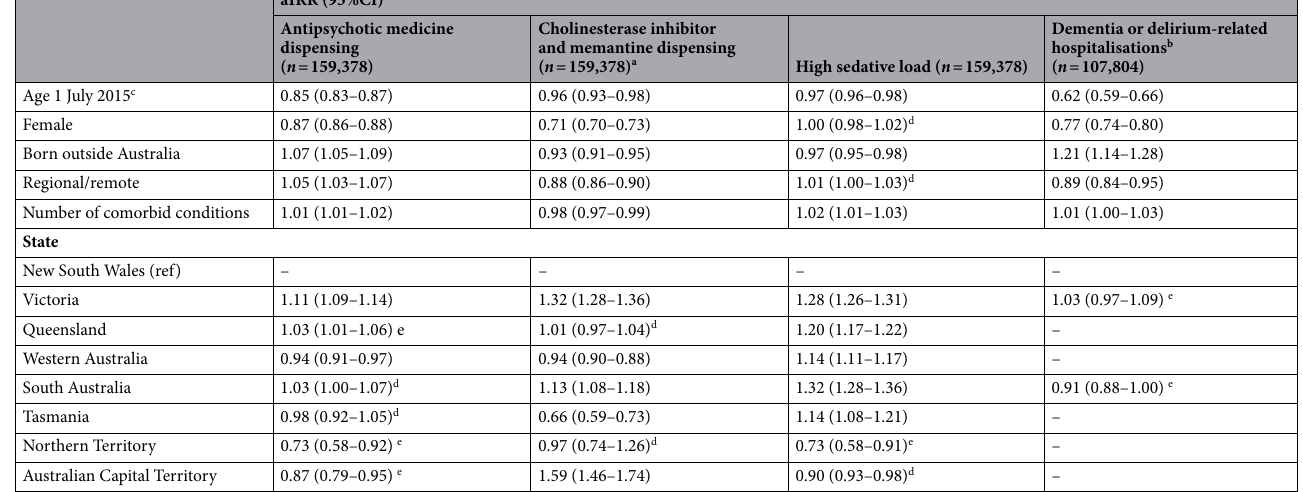
Table 3. Factors associated with clinical quality indicator performance, July 2015–June 2016. aIRR Adjusted incidence rate ratio, CI Confidence interval. a Adjusted for time since cohort entry. b New South Wales, Victoria, and South Australia only. c Scaled up to 10-year increments. d p > 0.05 after correction for multiple hypothesis testing. f p between .0125 and .05, not considered statistically significant after correction for multiple hypotheses